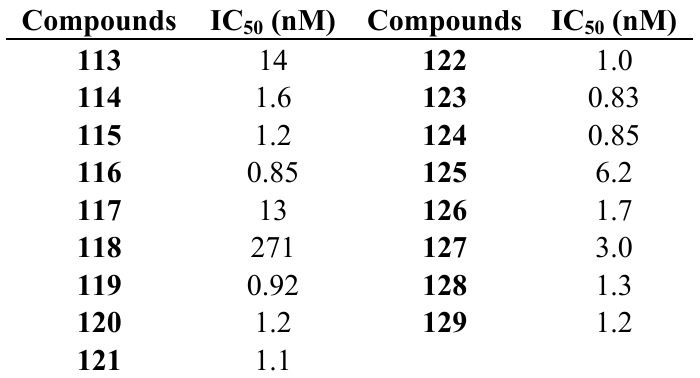
) of the test compounds. 50